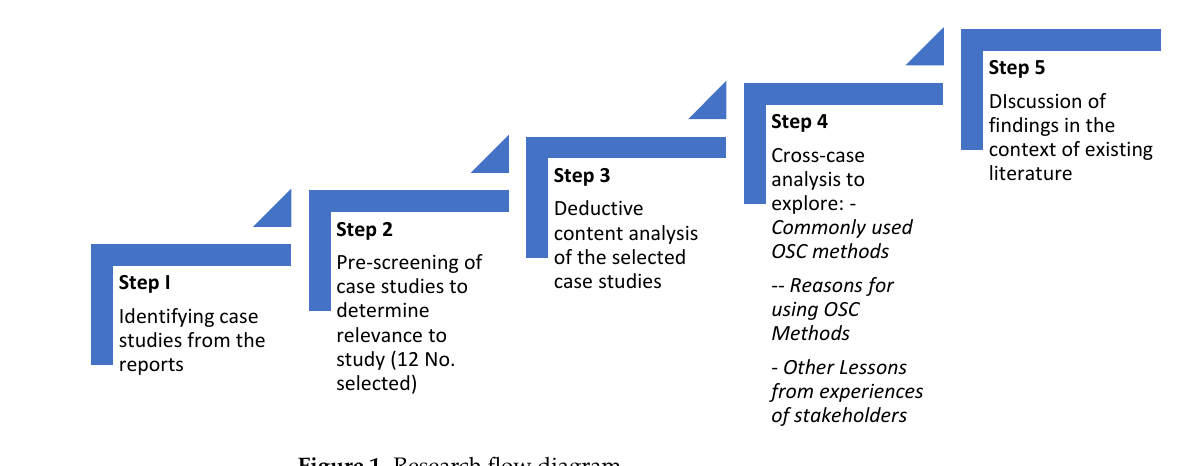
Figure 1. Research flow diagram.